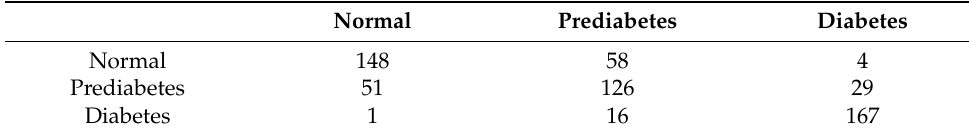
Table 3. Confusion matrix of the RF model.